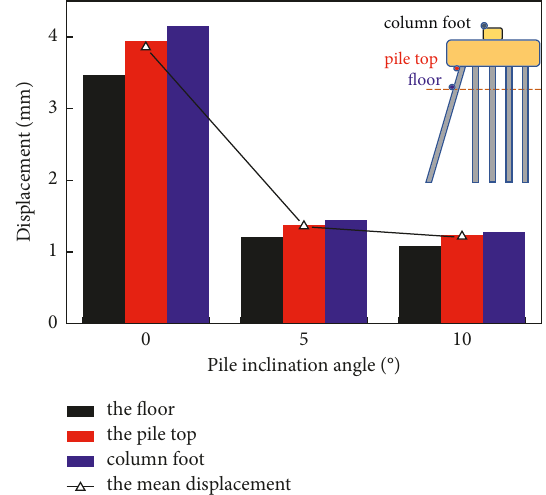
Figure 10: Contrast diagram of foundation